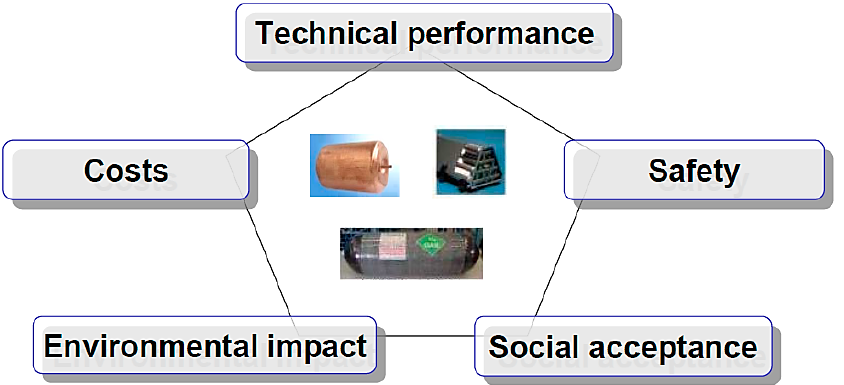
Figure 6. Multi-criteria evaluation for hydrogen storage tank design [59].